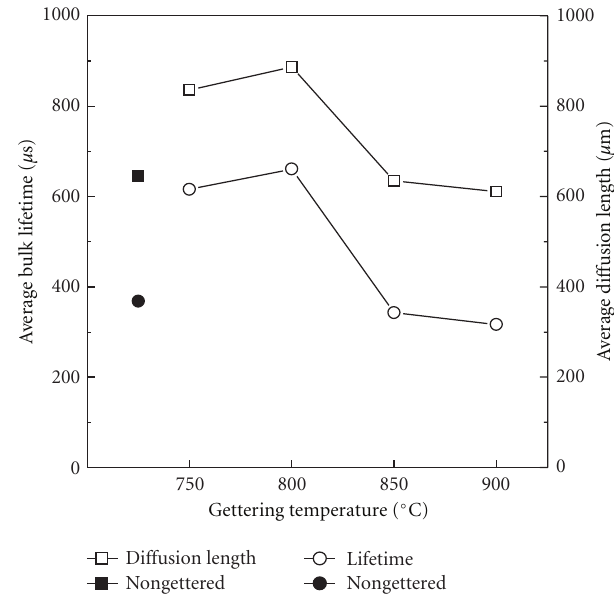
Figure 2: Resistivity as a function of gettering temperature.